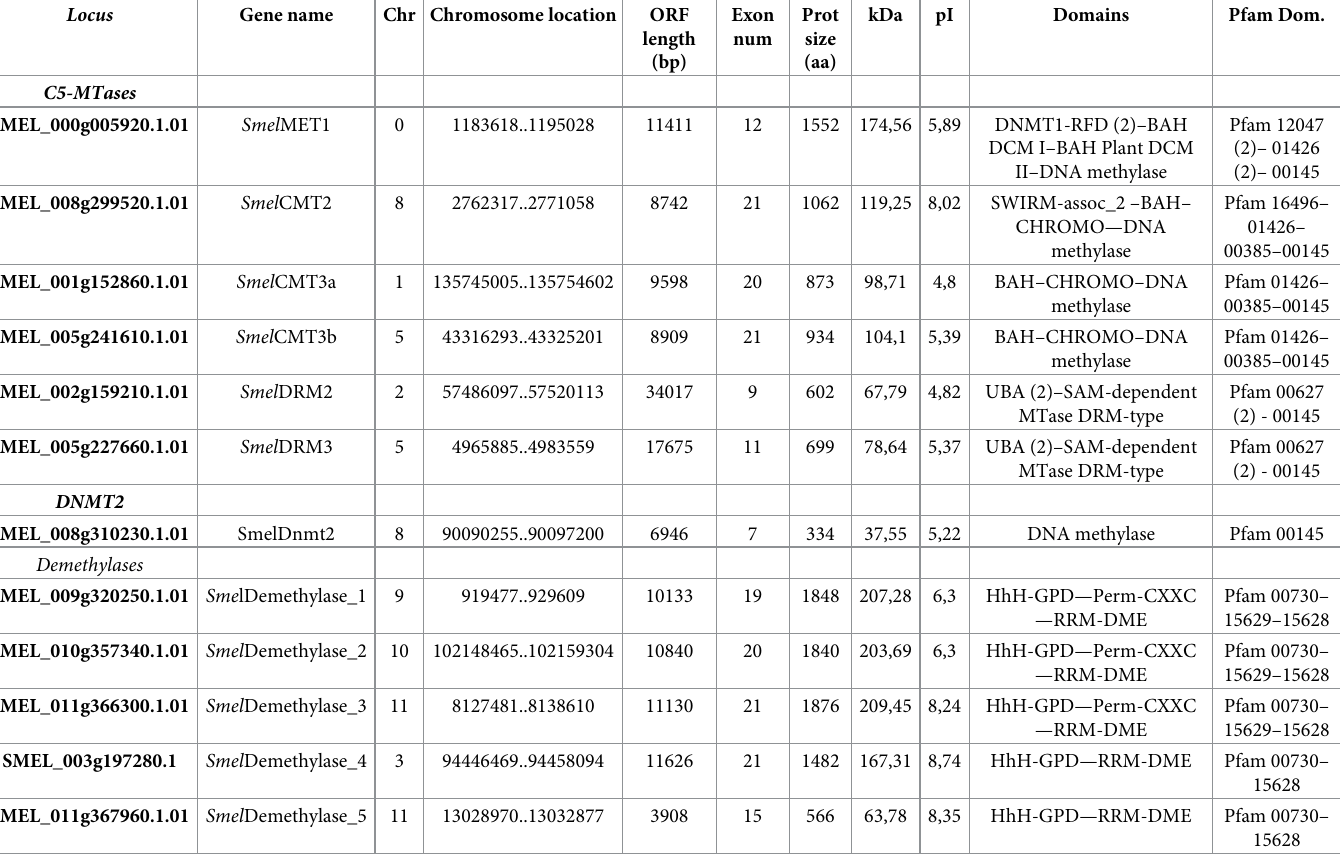
Table 1. Eggplant loci encoding C5-MTases and demethylases, their location and annotation of their various protein